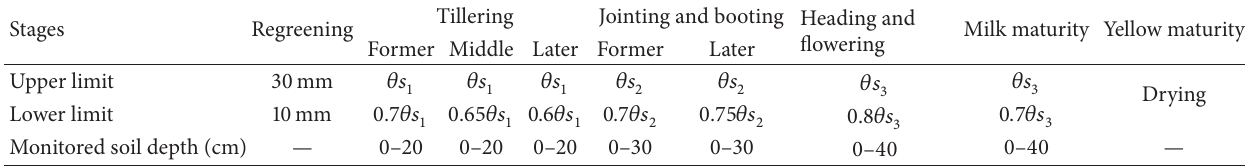
Table 1: Limits for irrigation in different stages of rice for non-flooding controlled